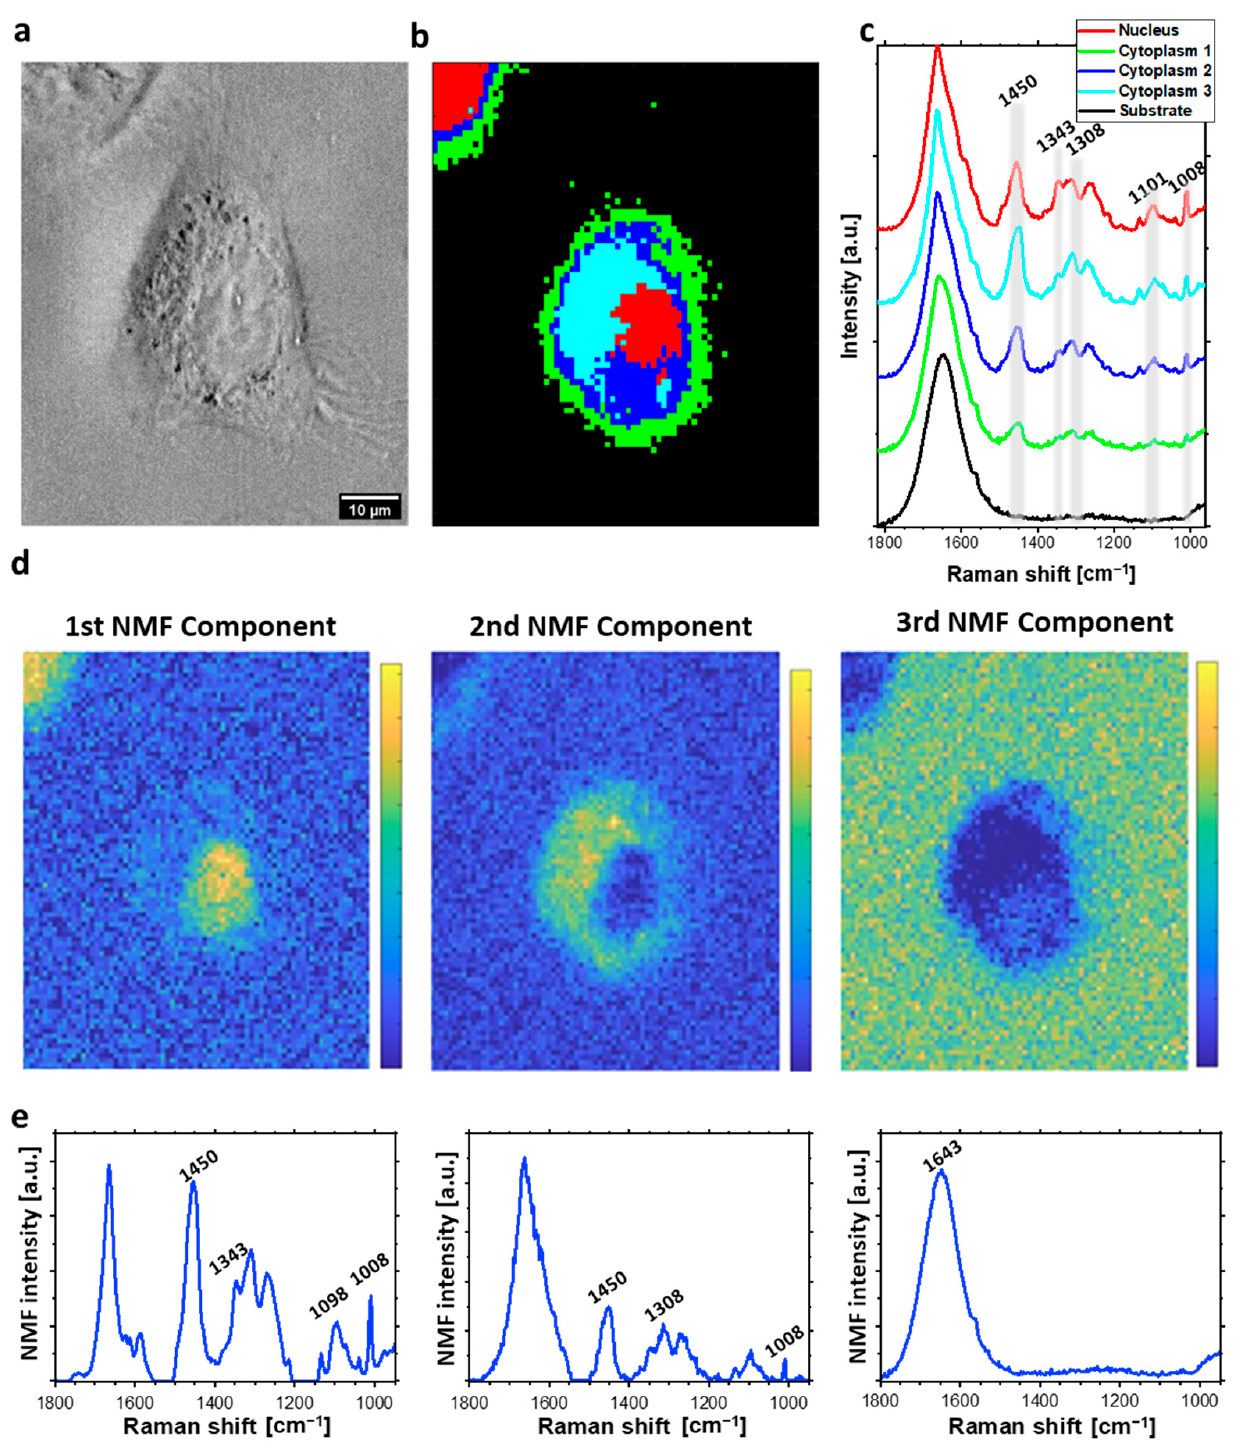
Figure 2. Raman imaging of control (untreated) HeLa cell: ( a ) The cell optical image; ( b ) HCA map; ( c ) HCA mean Raman spectra (color of each spectrum corresponds to color of the cluster in ( b )); ( d ) distribution of NMF components; ( e ) corresponding plots of NMF components.